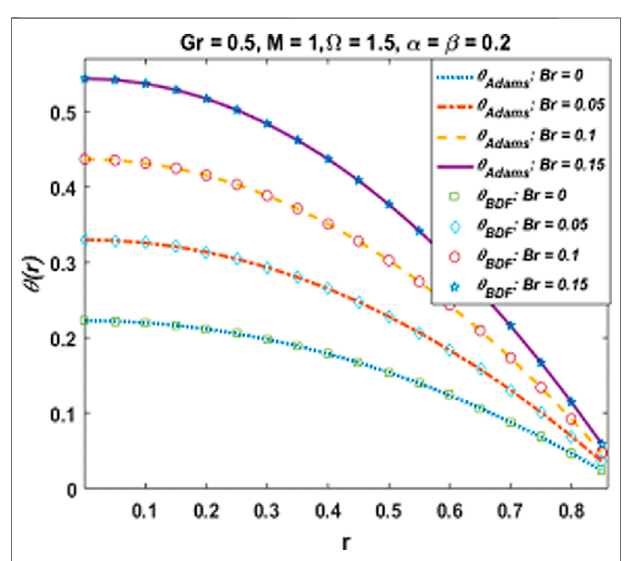
FIGURE 14 | Behavior of temperature pro fi le against heat generation